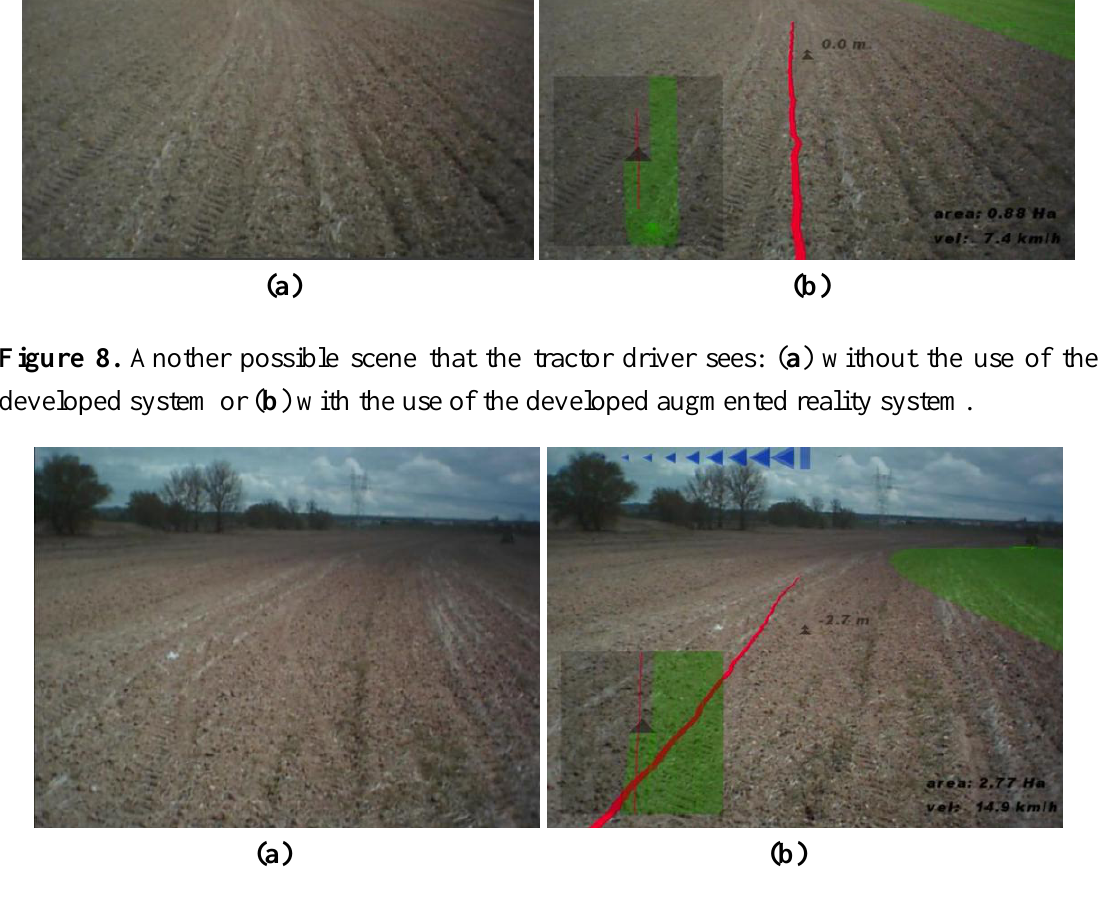
Figure 9. A possible scene that an observer sees: ( a ) without the developed system or ( b ) with the developed augmented reality